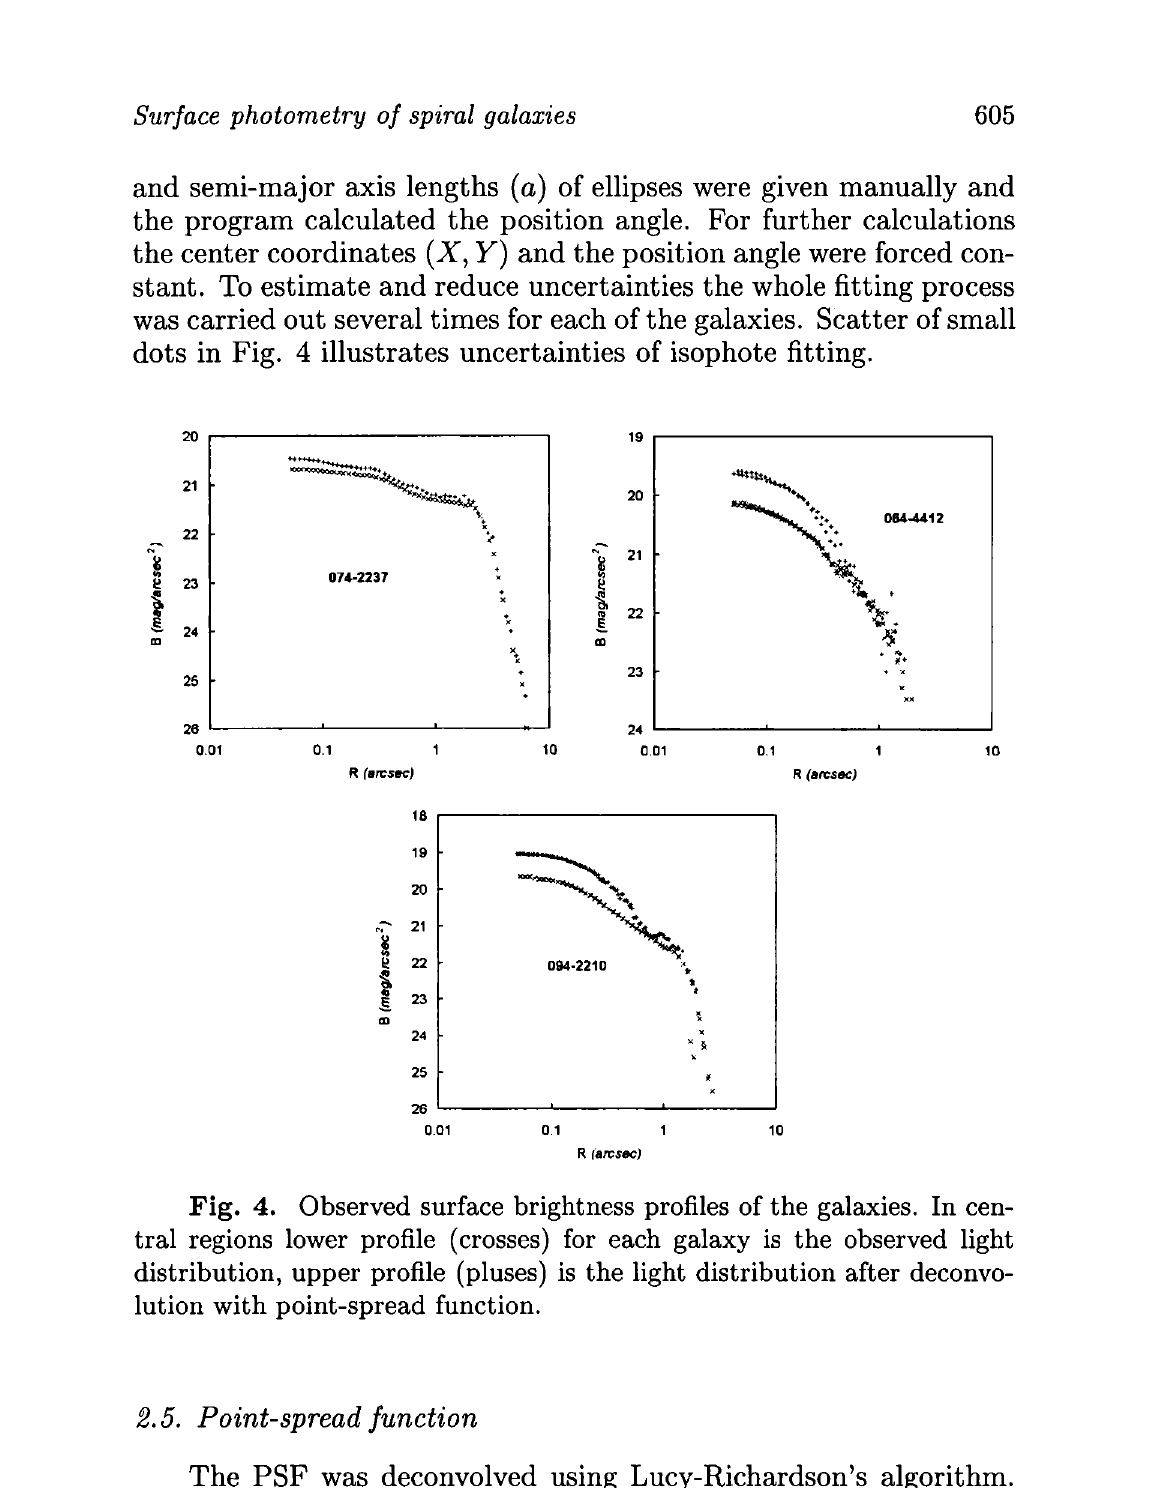
Fig. 4. Observed surface brightness profiles of the galaxies. In cen- tral regions lower profile (crosses) for each galaxy is the observed light distribution, upper profile (pluses) is the light distribution after deconvo- lution with point-spread